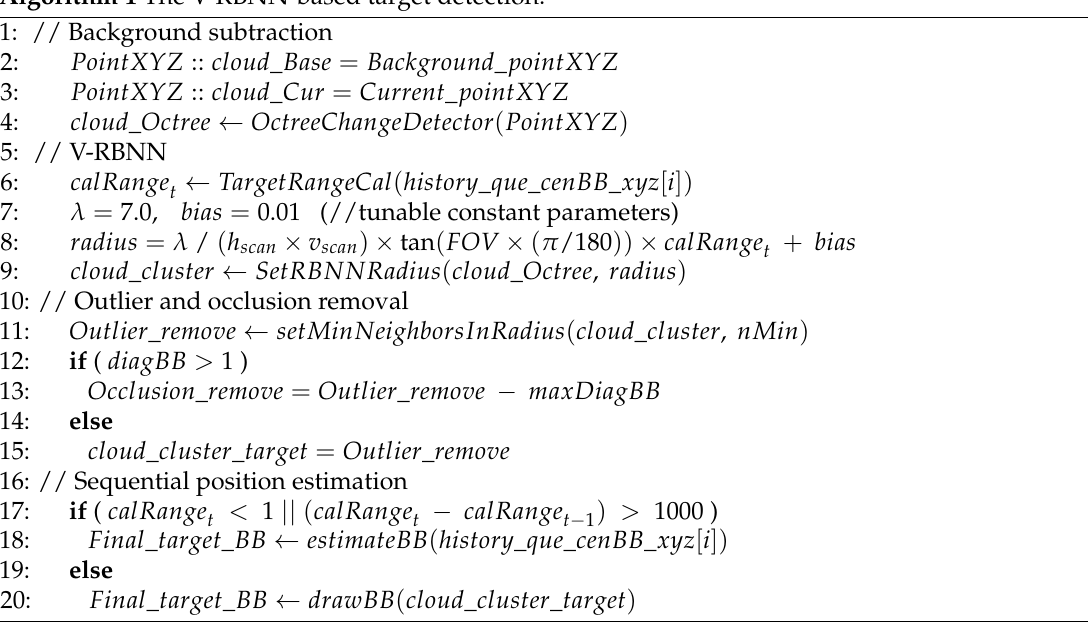
Algorithm 1 The V-RBNN-based target